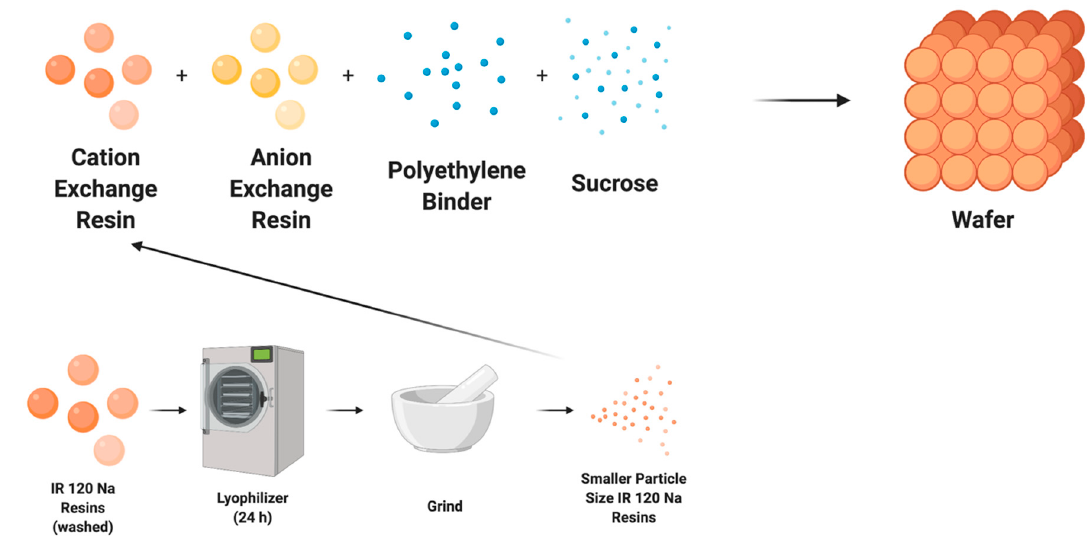
Figure 1. Illustration of typical wafer fabrication and particle size reduction (grinding) of ion exchange resins for wafer fabrication .